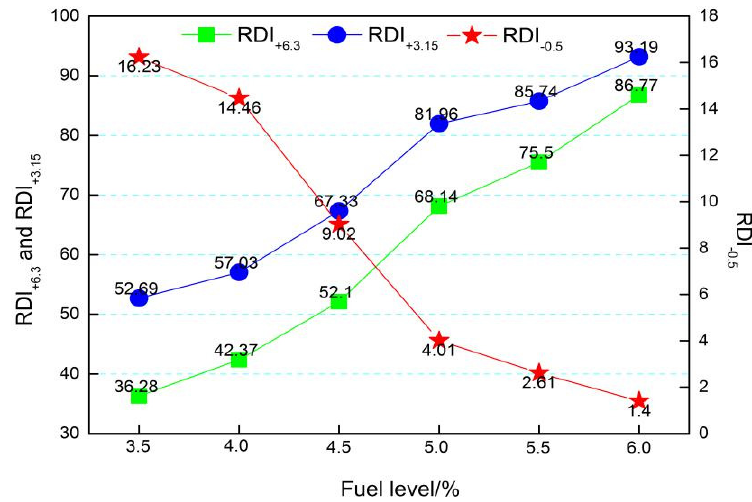
Figure 8. Effect of fuel level on the RDI of RVT sinter.